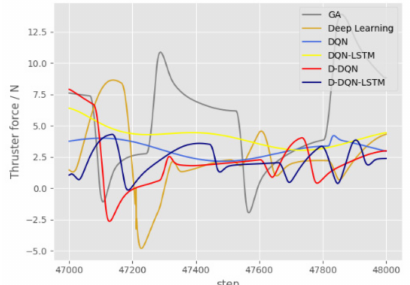
Figure 22. Thrust curve between 47,000 and 48,000 in a complicated environment.